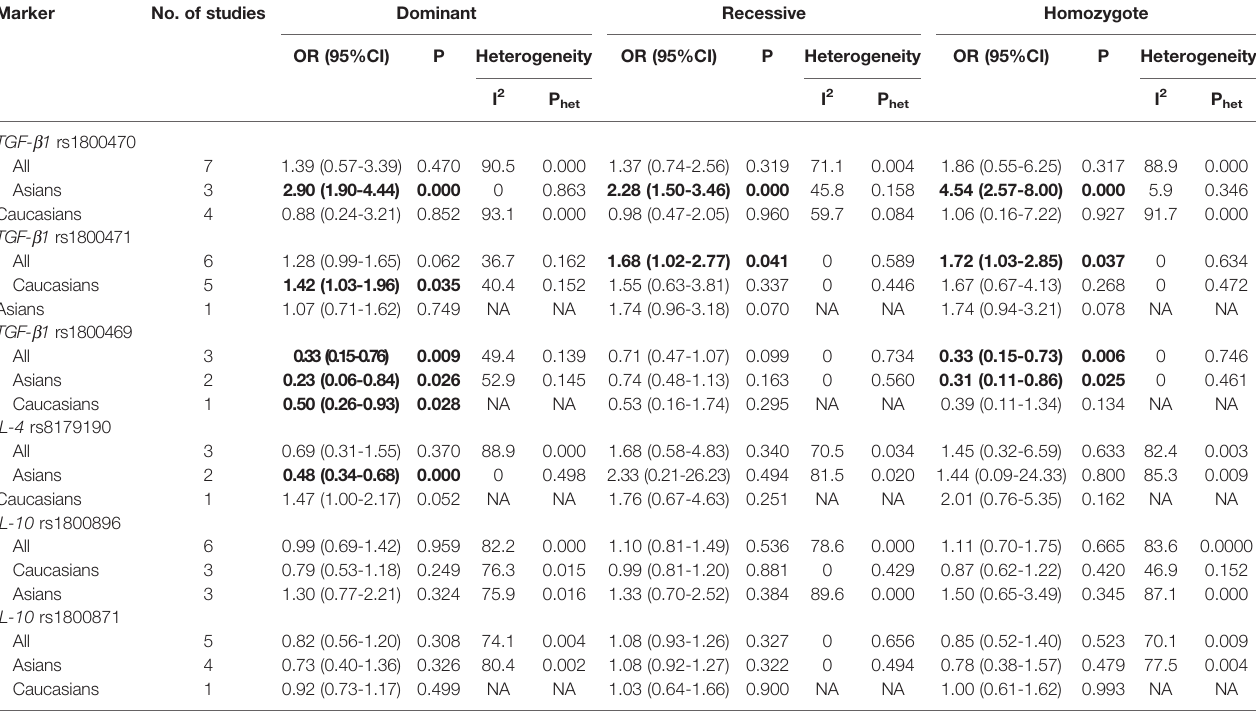
TABLE 2 | The results of meta-analysis.